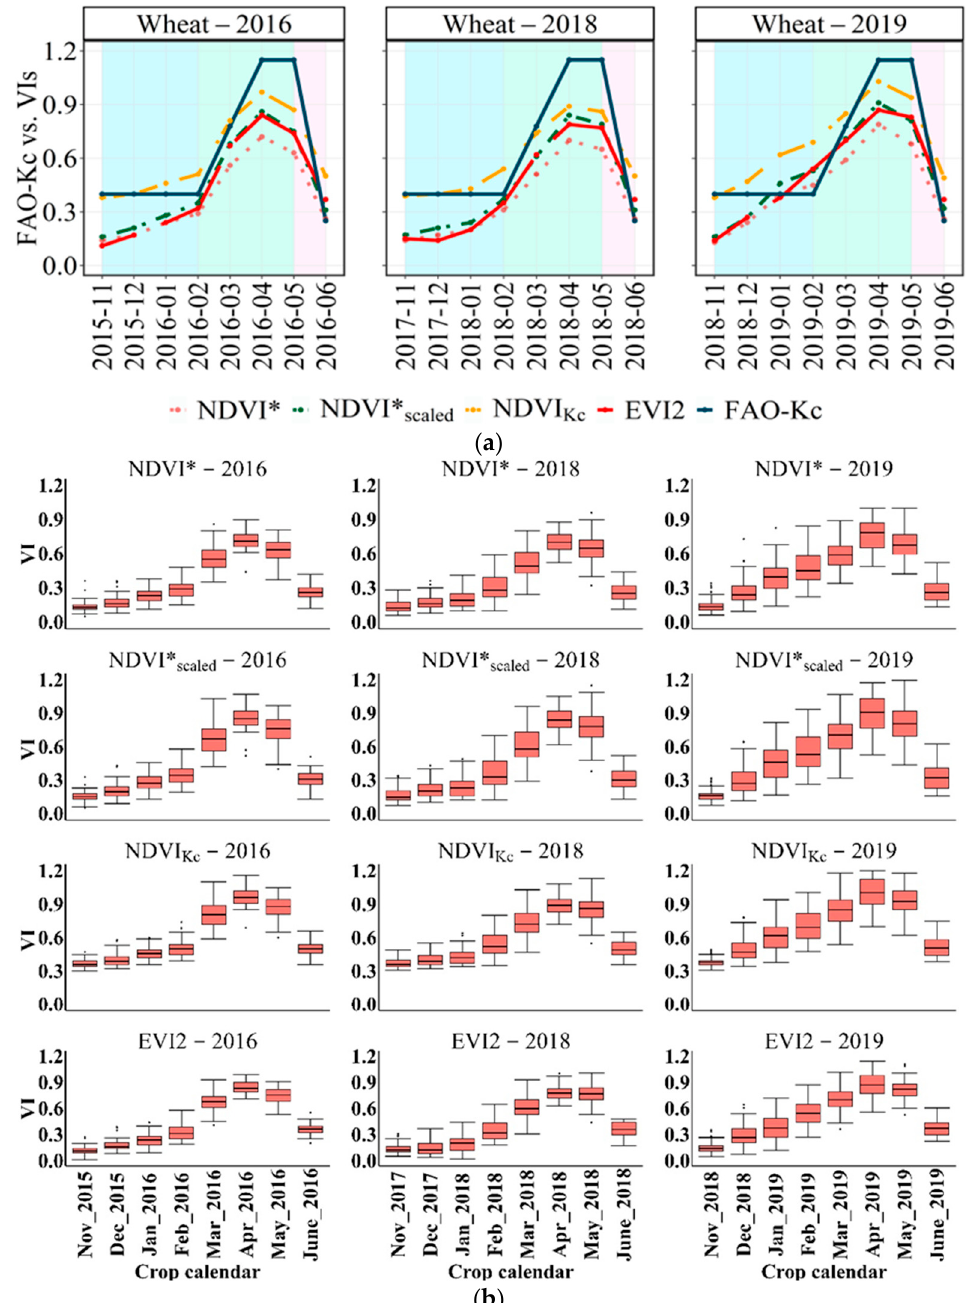
Figure 7. ( a ) Comparison of FAO-Kc with VI, background colors show different crop growth stages, i.e., blue: initial stage, green: middle stage, pink: end-stage; ( b ) Boxplots of estimated VIs of wheat during growing seasons.